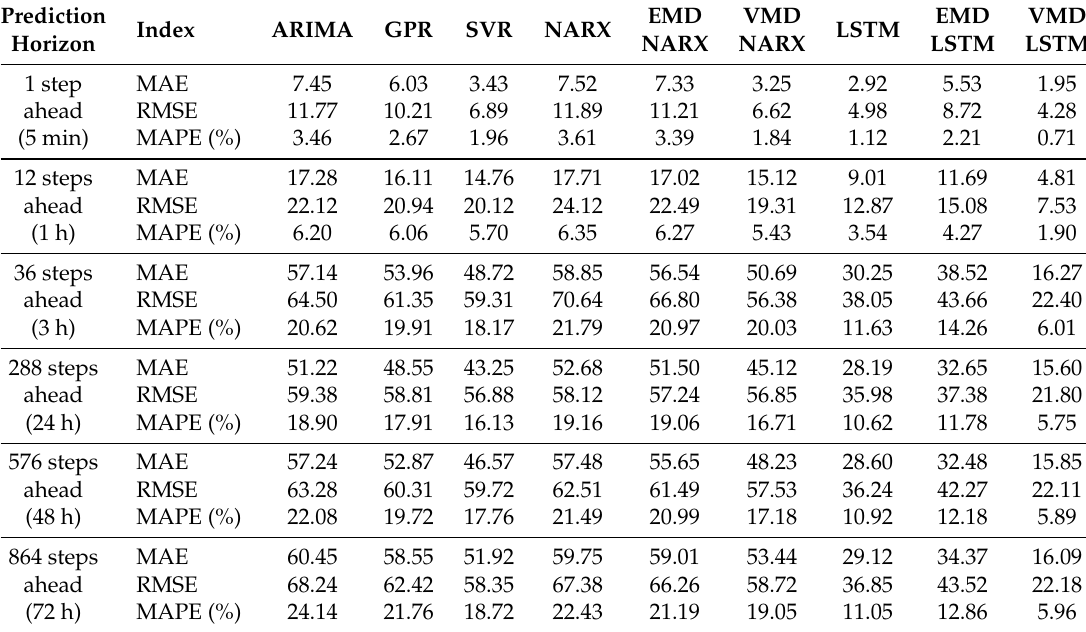
Table 2. Load forecasting errors of different